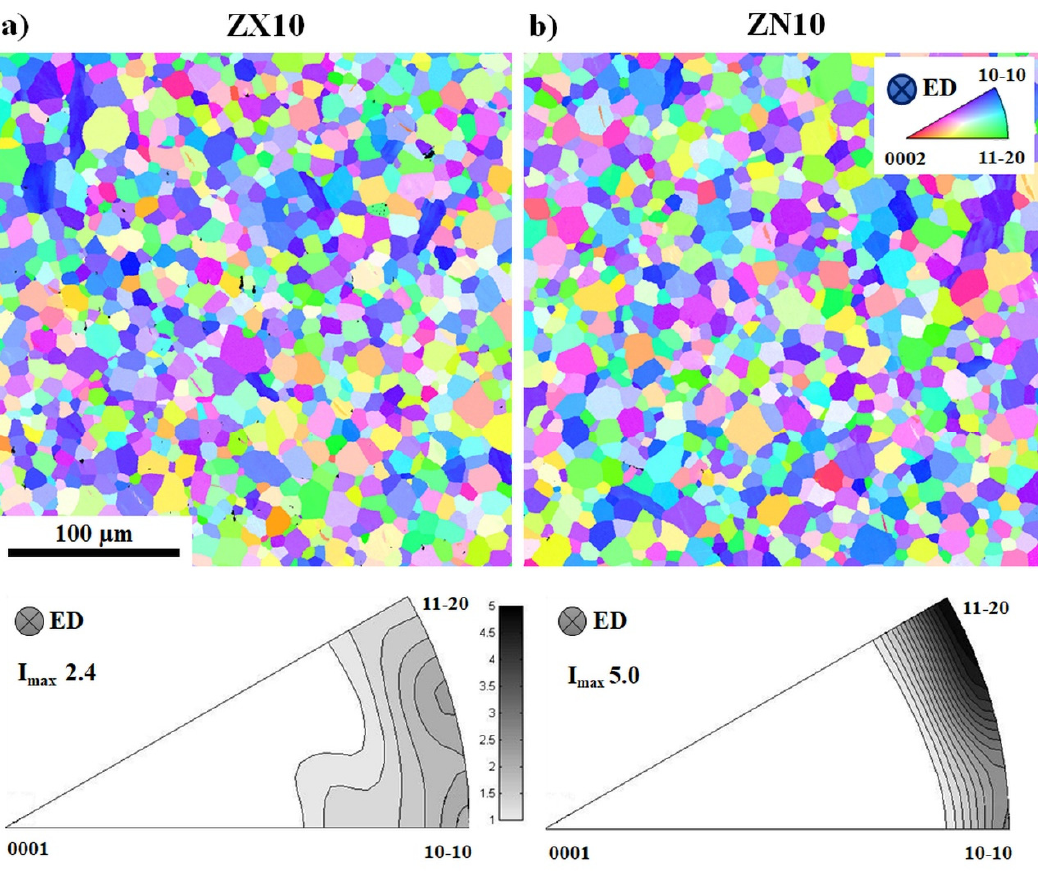
Figure 1. Microstructure and texture of ( a ) ZX10 and ( b ) ZN10 alloys. ED is perpendicular to the image plane of orientation maps and texture triangles.